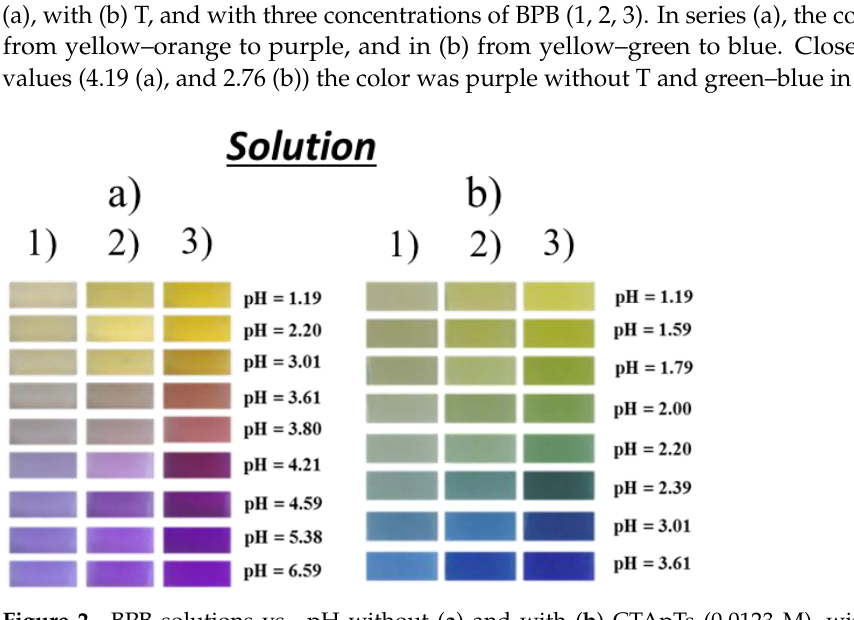
Figure 2. BPB solutions vs. pH without ( a ) and with ( b ) CTApTs (0.0123 M), with increasing con- centrations of indicator: (1) 1.42 × 10 −5 M; (2) 2.91 × 10 −5 M; (3) 5.72 × 10 −5 M. concentrations of indicator: (1) 1.42 × 10 − 5 M; (2) 2.91 × 10 − 5 M; (3) 5.72 × 10 − 5